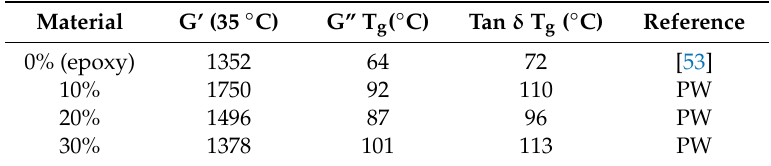
Table 6. DMA parameters.